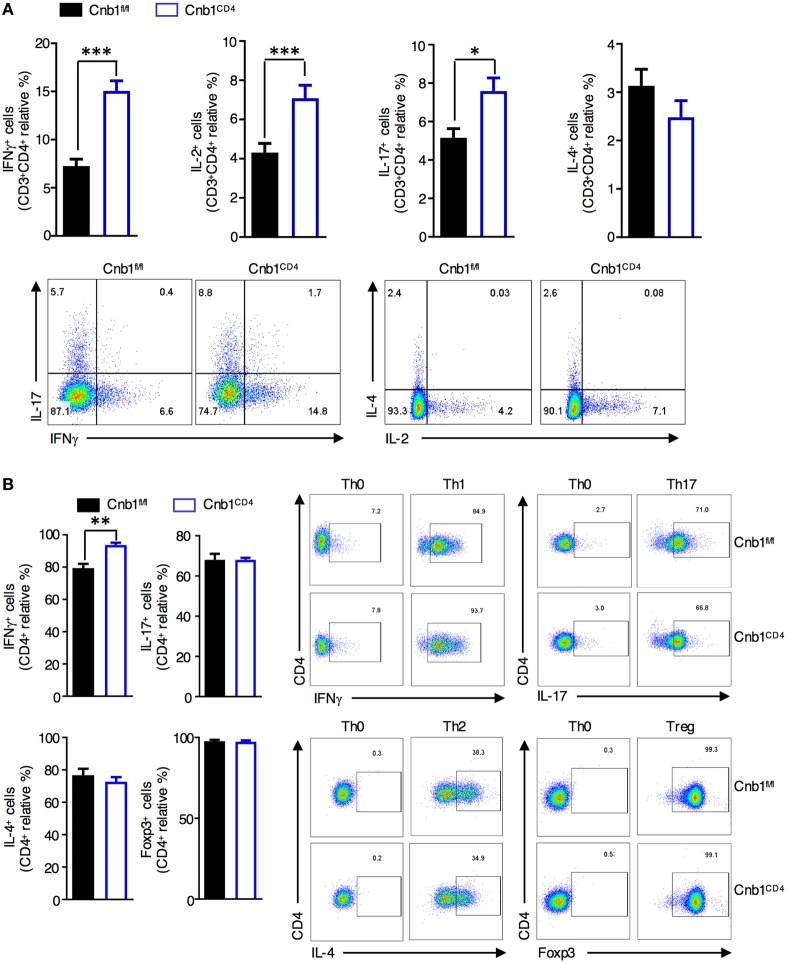
Cnb1-deficient CD4+ T cells produce more interferon (IFN)γ. (A) Proportion of CD4+ T cells producing IFNγ, IL-2, IL-17, or IL-4 in colonic-lamina propria (LP) isolated from Cnb1fl/fl and Cnb1CD4 mice. (B) Purified naïve CD62LhighCD44neg CD4+ T cells from the spleens of Cnb1fl/fl and Cnb1CD4 mice were cultured under conditions to promote Th0, Th1, Th17, Th2, and Treg cells. T cells were collected after 5 days and stimulated with PMA/ionomycin for 5 h, with the addition of Brefeldin A for the final 4 h. Cells were stained for intracellular IFNγ, IL-17, IL-4, and FoxP3, and the proportion of CD4+ T cells producing these cytokines was assessed by flow cytometry. Representative flow-cytometric dot plots are shown. Data represent the means ± standard error of two or three independent experiments (n = 3–4 mice per group, per experiment). *P < 0.05; **P < 0.01; ***P < 0.005 (two-tailed, unpaired Student’s t-test). Abbreviations: Th0, naïve T cell; Th1, Type-1 T helper cell; Th2, Type-2 T helper cell; Th17, T helper 17 cell; Treg, regulatory T-cell.